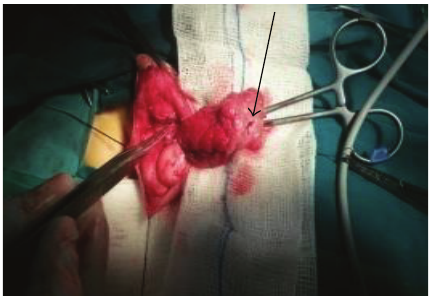
Figure 1: Progressive dissection with recognition and ligation with Vicryl 4-0 of the feeding vessels of the hemangioma. The ulceration on its scrotal part is observed (arrow).